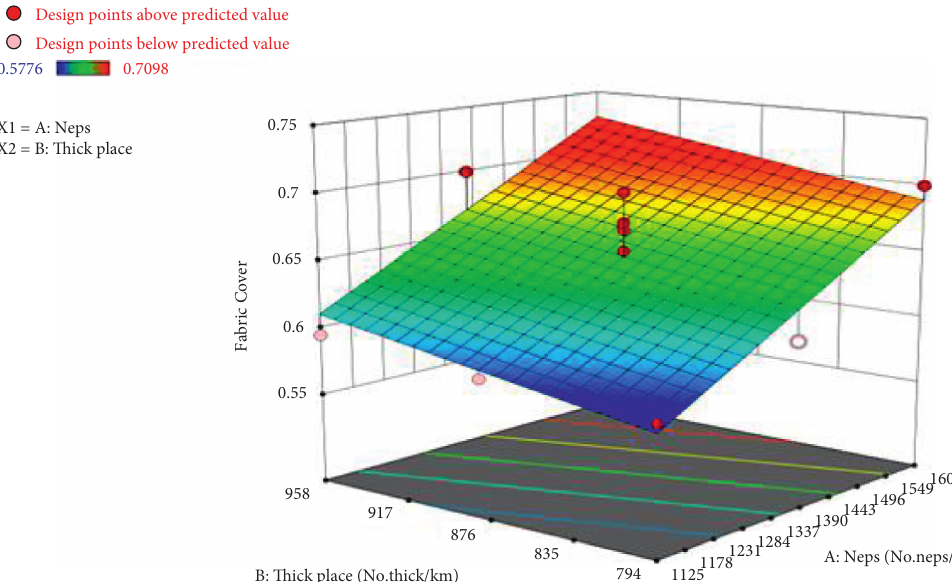
Figure 7: The regression model of the response with the two-factor